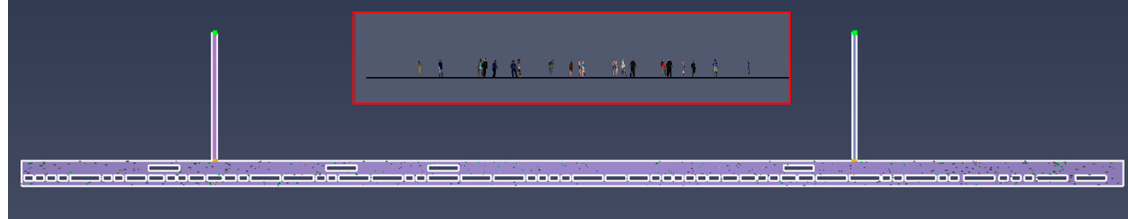
Figure 7. Simplified model diagram of underground interchange in Pathfinder software.